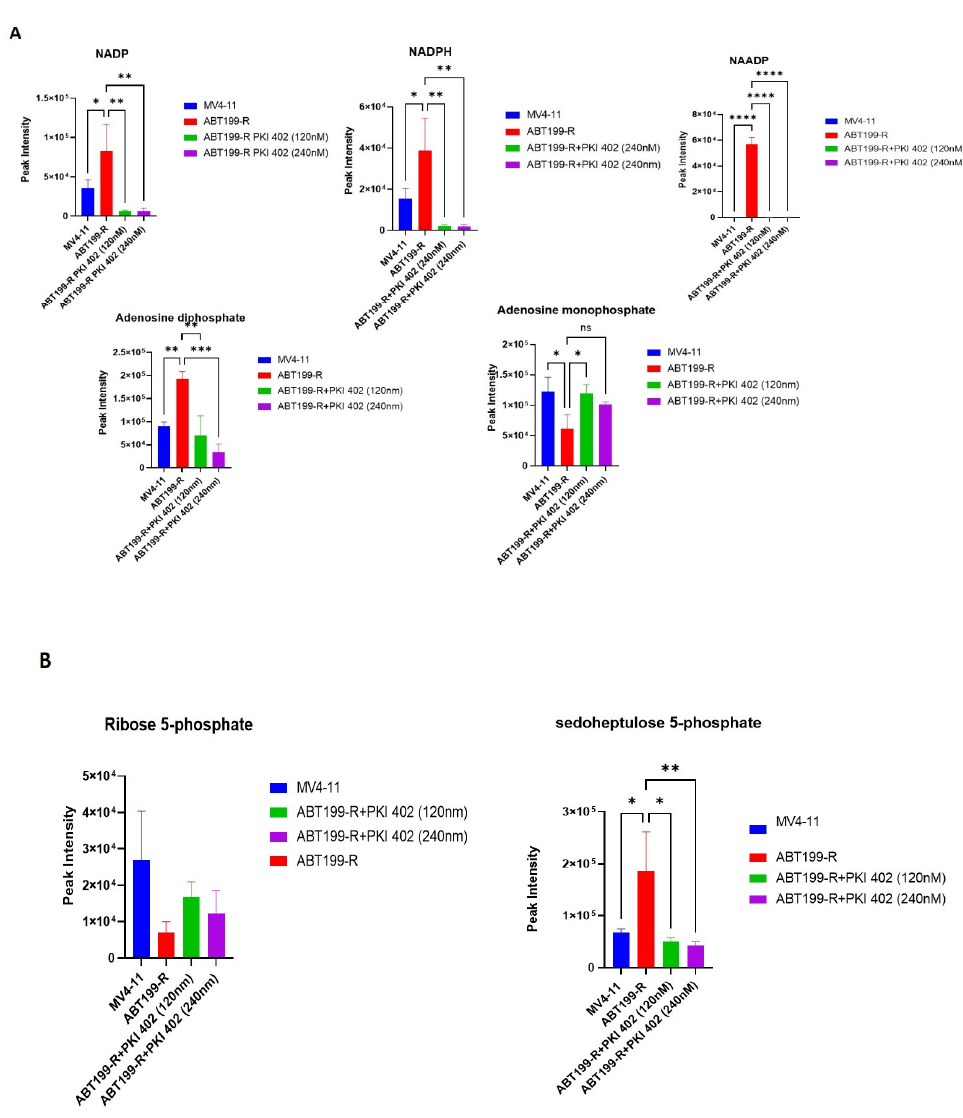
Figure 7. Pentose phosphate pathway (PPP) and energy metabolites modified in ABT199-R cells. ( A ) The density of metabolic features involved in regulating the energy metabolism of MV4-11 cells, ABT199-R cells, and ABT199-R cells treated with PKI-402. ( B ) Metabolites involved in PPP. ns = non-significant, * p < 0.05, ** p < 0.01, *** p < 0.001, and **** p < 0.0001.